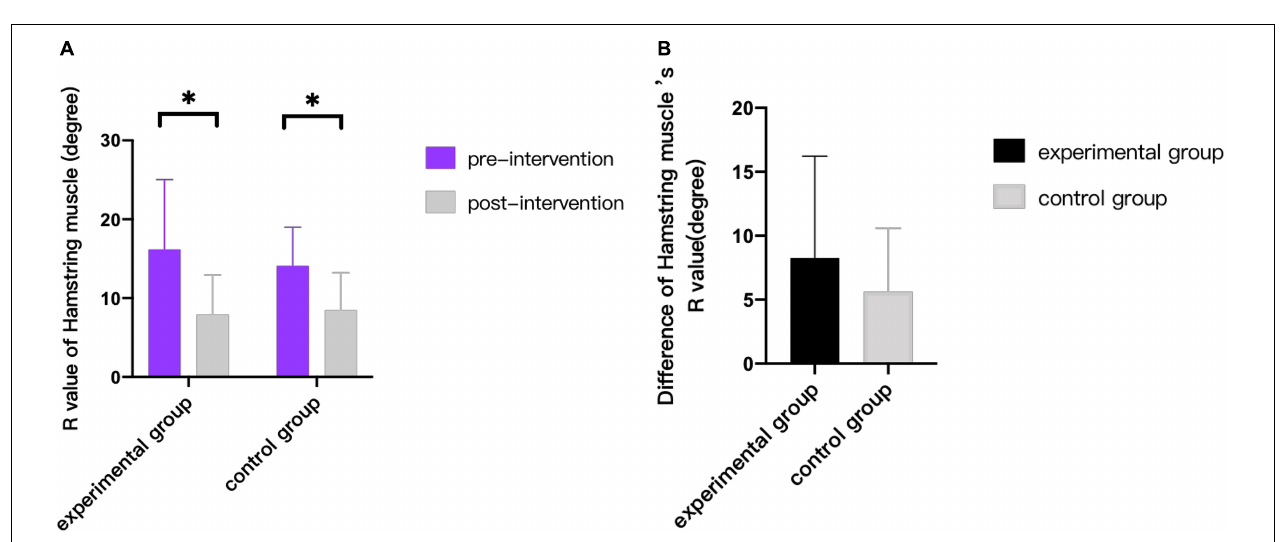
FIGURE 4 | Comparison of R value of hamstring Muscle. * indicates intra-group p <